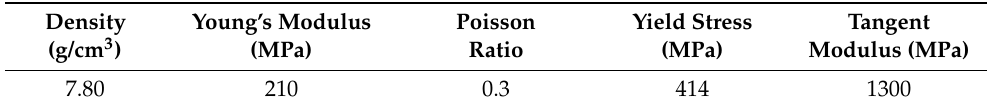
Table 5. Material parameters of